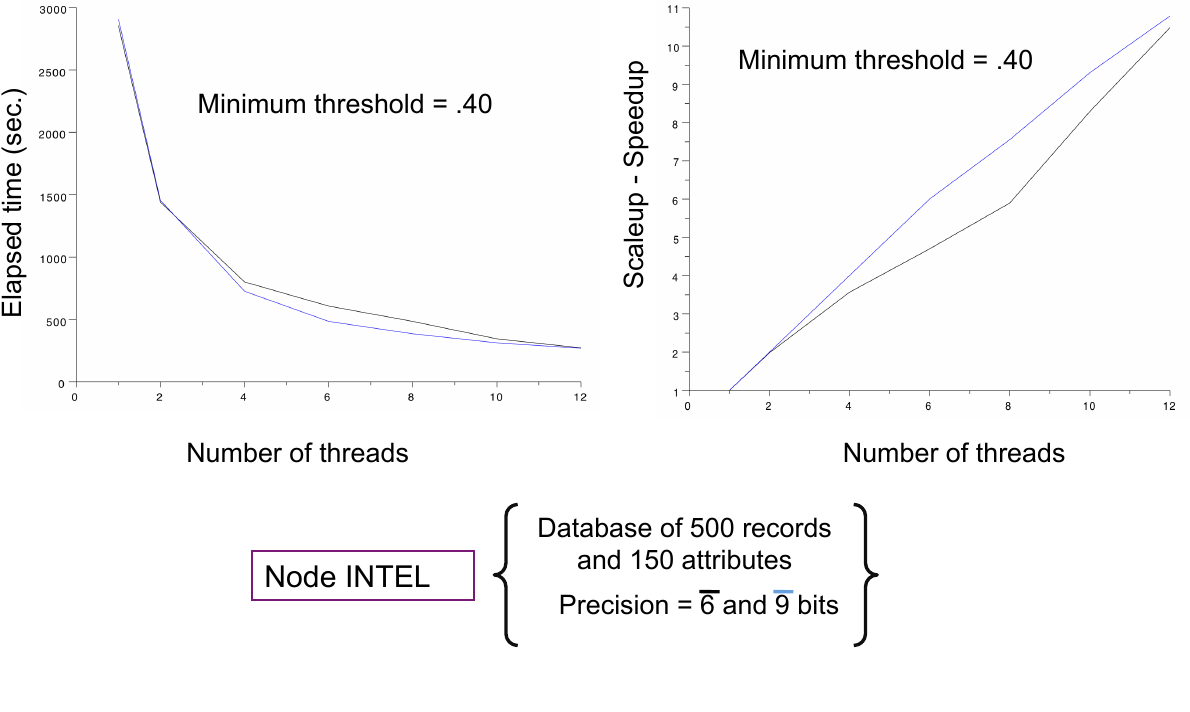
Figure 6. Execution time and Speedup related to the number of threads on Intel nodes for synthetic database of 150 attributes at precisions 6 and 9 bits.